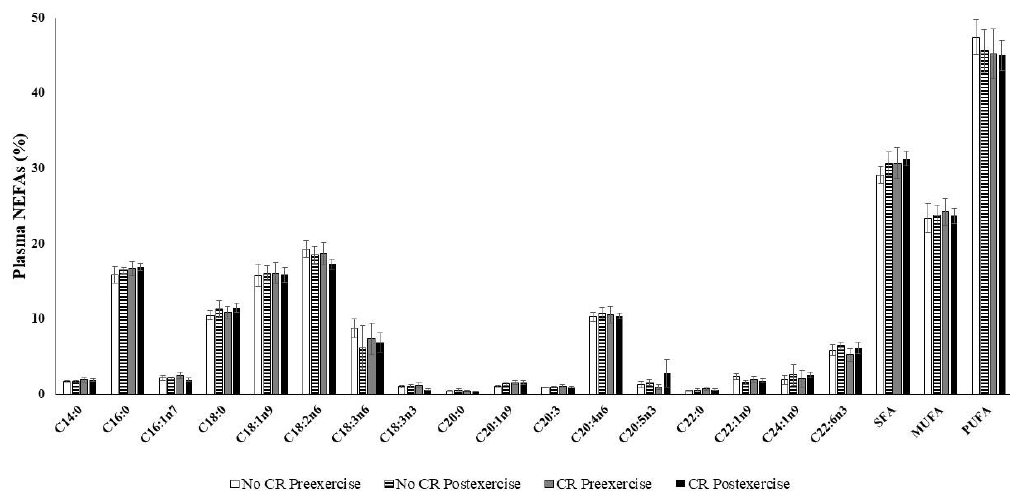
Figure 2. Content of non-esterified fatty acids in plasma, 20:3 was the 20:3n6 and 20:3n3 mixture. Values are represented as mean ± SEM. Statistical analysis: two-way ANOVA, p < 0.05. CR: Calorie restriction.